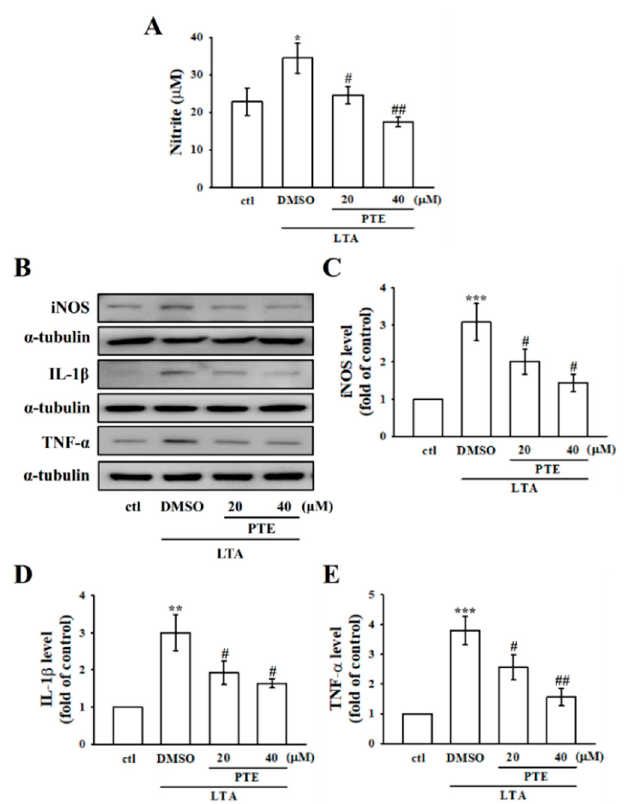
Figure 2. Effects of PTE on inflammatory mediators and cytokines ( A – E ). Cells were treated with 0.1% dimethyl sulfoxide (DMSO) or PTE (20 and 40 µ M) for 30 min, and then stimulated by LTA (5 µ g/mL) for 24 h. PTE reduces NO production ( A ), and protein expression of iNOS ( C ), IL-1 β ( D ), and TNF- α ( E ) in LTA-induced RAW cells. Data expressed are the means ± S.E.M. ( n = 4); * p < 0.05, ** p < 0.01, and *** p < 0.001 vs. control cells; # p < 0.05, and ## p < 0.01 vs. PTE pretreated cells.